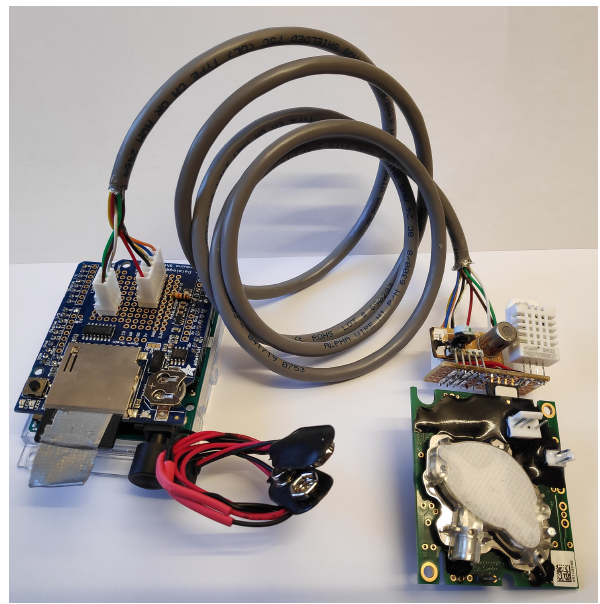
Figure 1. Photo of the CH 4 –CO 2 –RH– T logger described in the